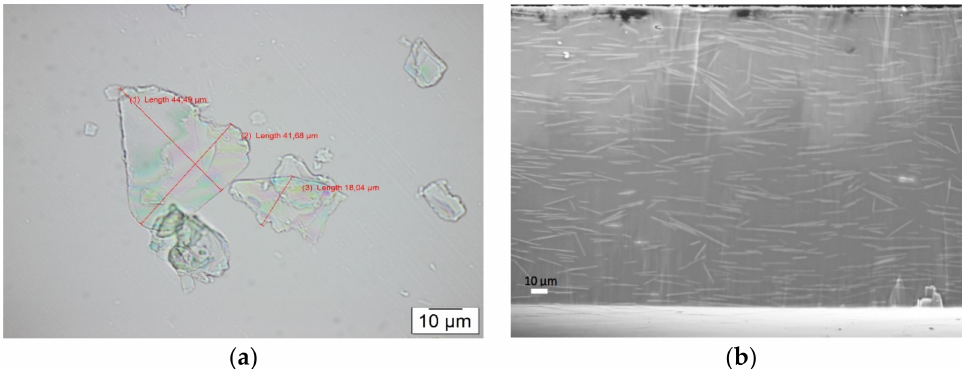
Figure 1. ( a ) Optical micrographs of mica powders, showing size of the flakes, ( b ) SEM cross section of PVB filled with 25 vol% of mica flakes showing random orientation of the